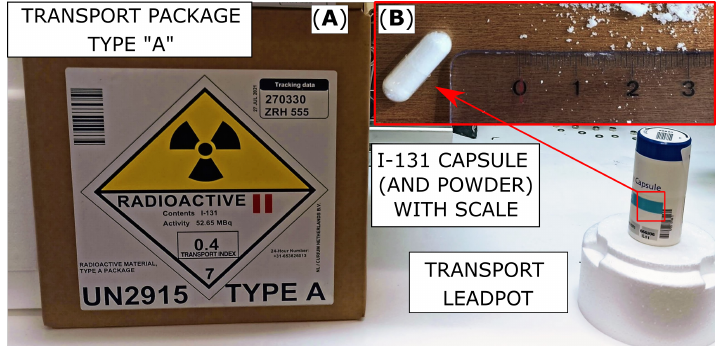
Figure 2. Standard elements of the transport packaging of the radiopharmaceutical 131 I. ( A ) Type-A package. The lead container, held securely in polystyrene foam inside a cardboard box. ( B ) Gelatin capsule and Na 131 I powder.